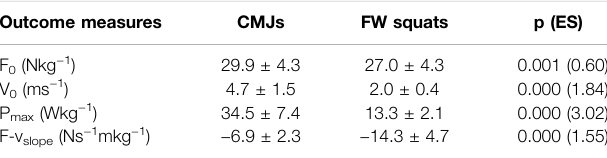
TABLE 2 | Descriptive statistics of force-velocity outcome variables calculated from countermovement jumps and fl ywheel squats. Outcome measures